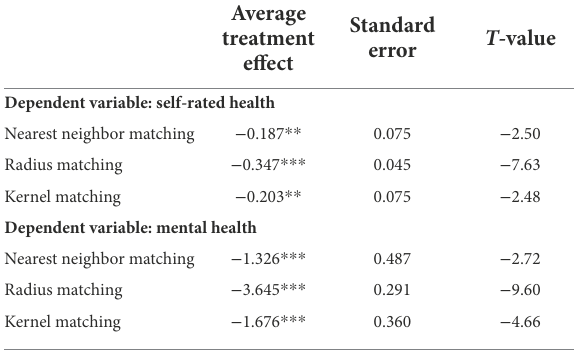
TABLE 3 Propensity score matching results (propensity score matching; China Health and Retirement Longitudinal Study, China, 2018).